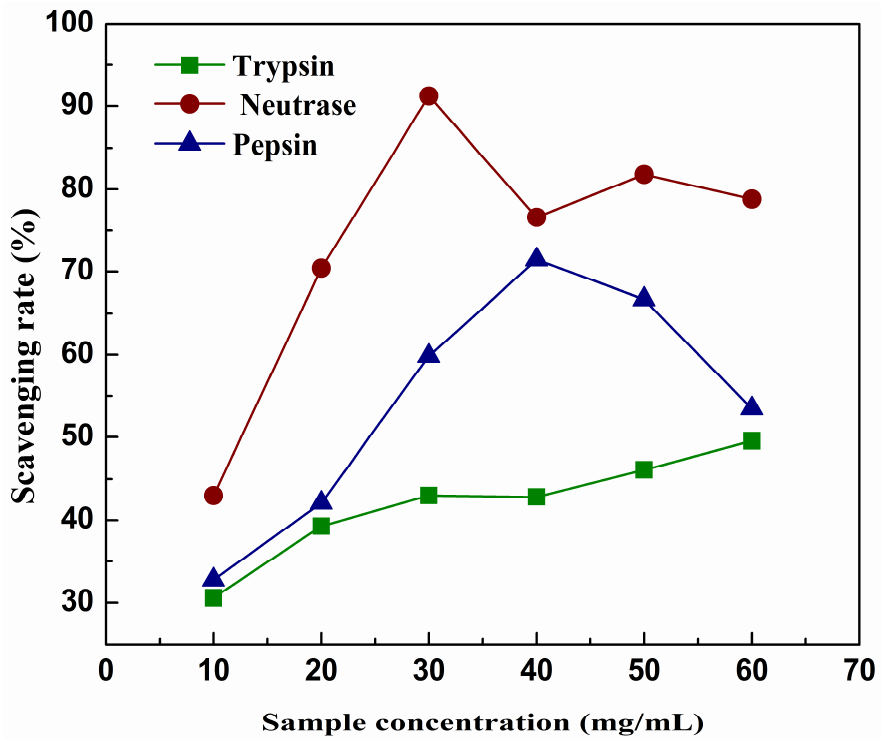
Figure 3. Antioxidant activities of the hydrolysates on linoleic acid emulsion in the FTC method during 4 h hydrolysis by trypsin, neutrase and pepsin with different concentrations. Results represent means ± SD of three independent experiments.